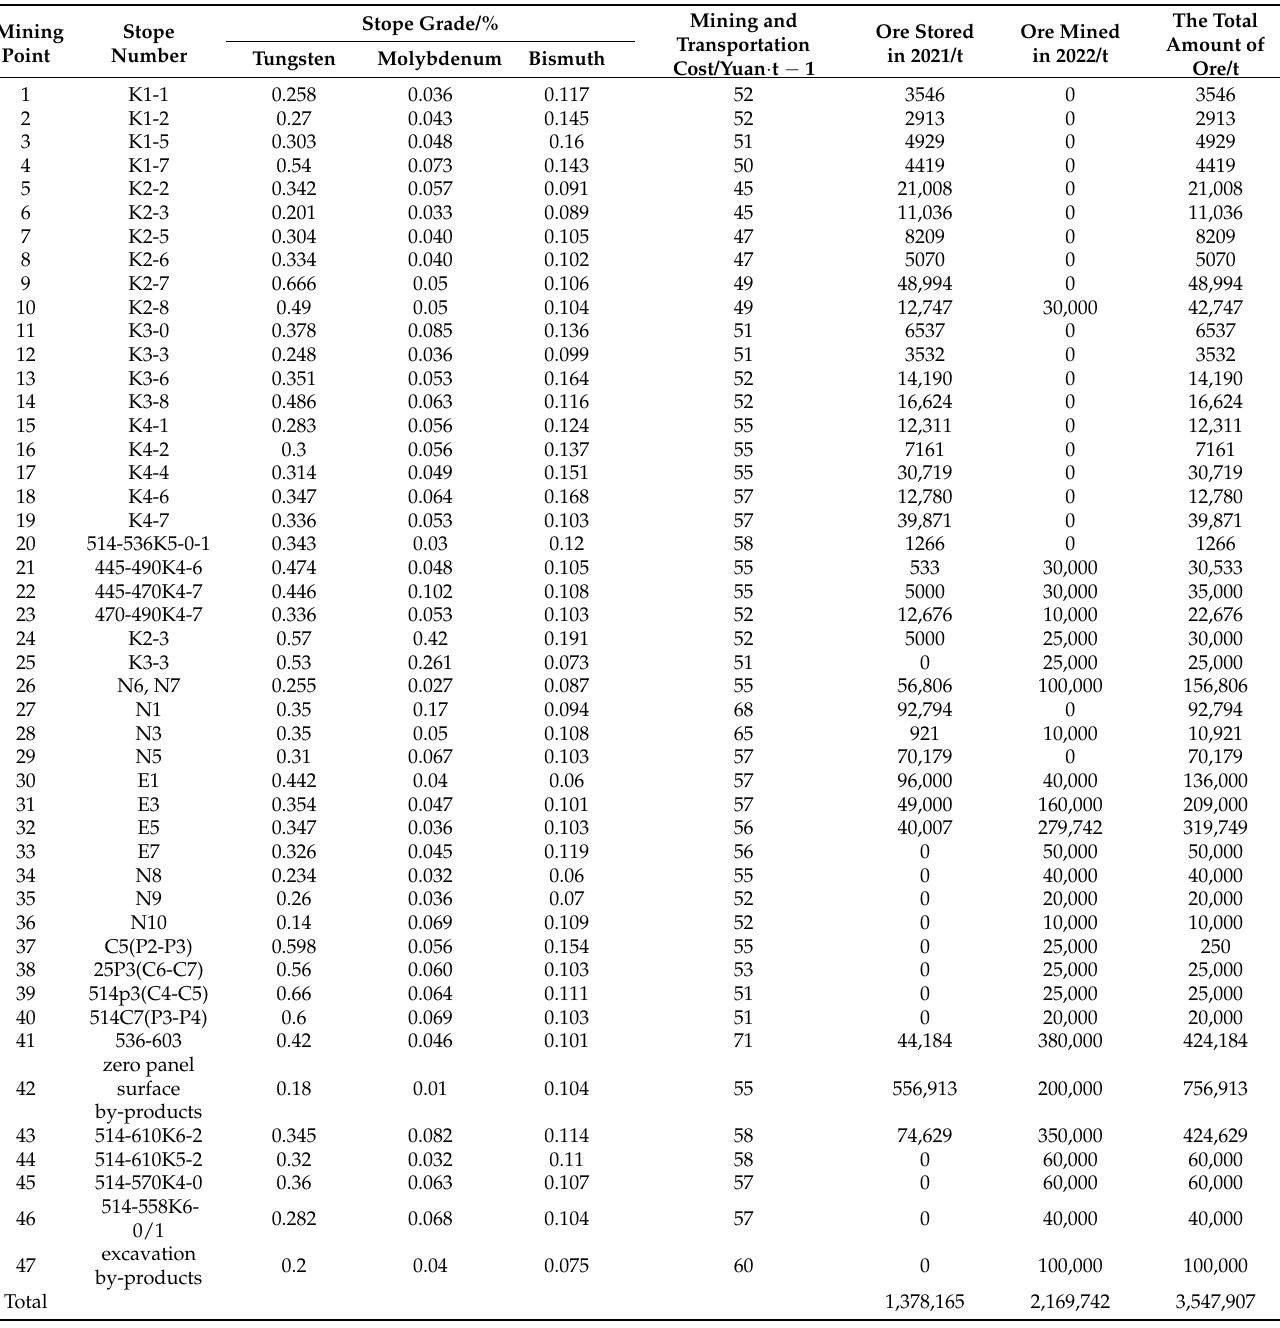
Table 1. Ore grade and comprehensive production index of each mining